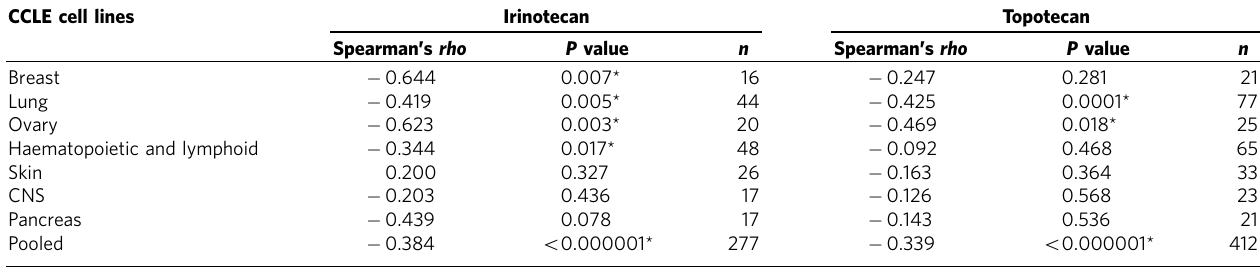
Table 3 | Correlation between cancer cell line CES values and IC 50 s for irinotecan and topotecan in CCLE cancer cell lines. CCLE cell